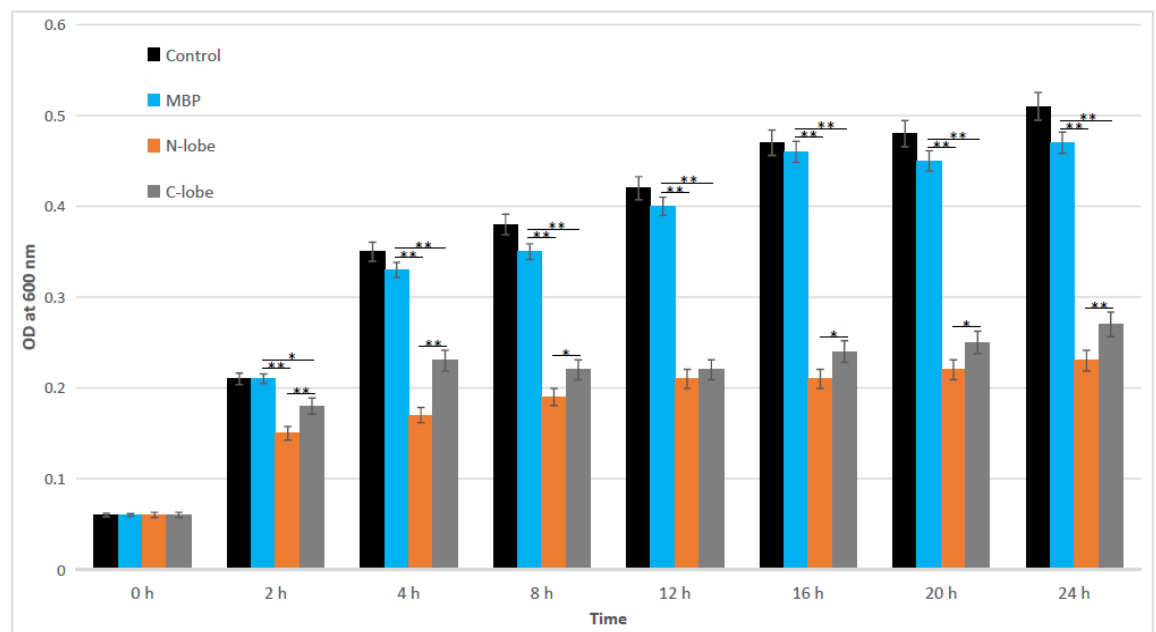
Figure 7. Analysis of iron-dependent bacterial growth inhibition. The x-axis represents time, and the y-axis represents the light absorption value at 600 nm. Values were described as mean ± SE ( n = 3). Asterisks (* p < 0.05; ** p < 0.01) indicated the statistically significant differences between treatments. MBP: maltose binding protein; OD: optical